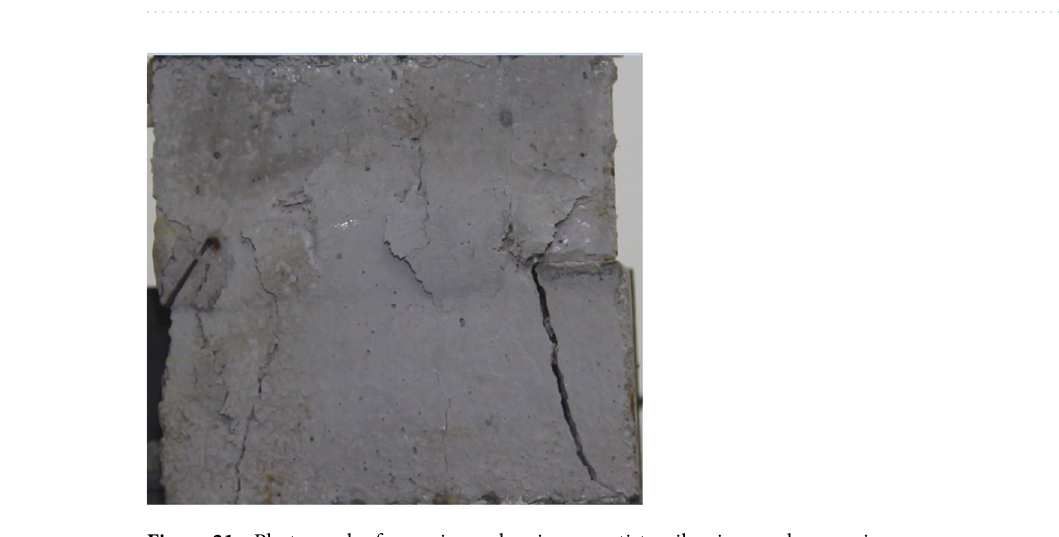
Figure 21. Photograph of a specimen showing an anti-tensile wing crack appearing.